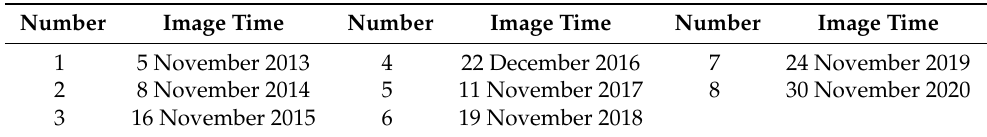
Table 1. GF-1 image data.